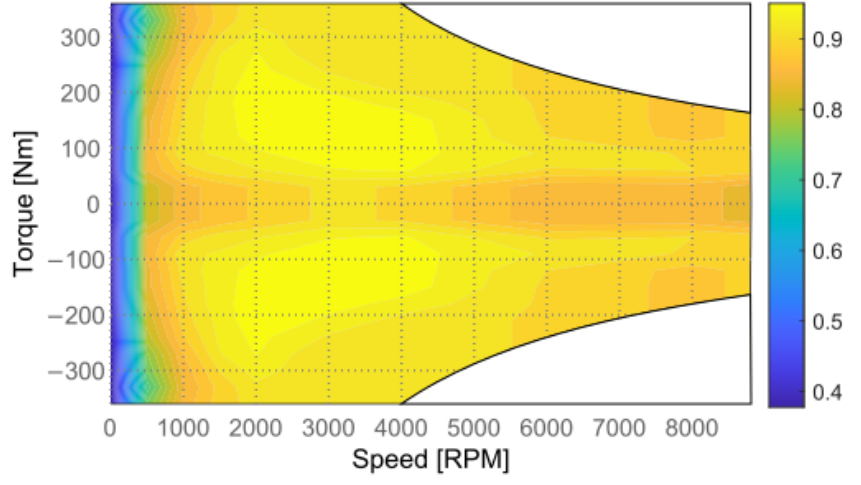
Figure 12. Efficiency map of the 150 kW PMSM.